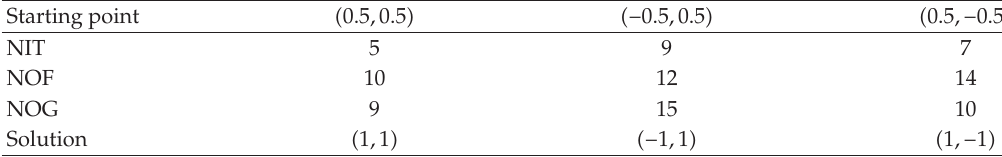
Table 3: Numerical results of Example 4.3.